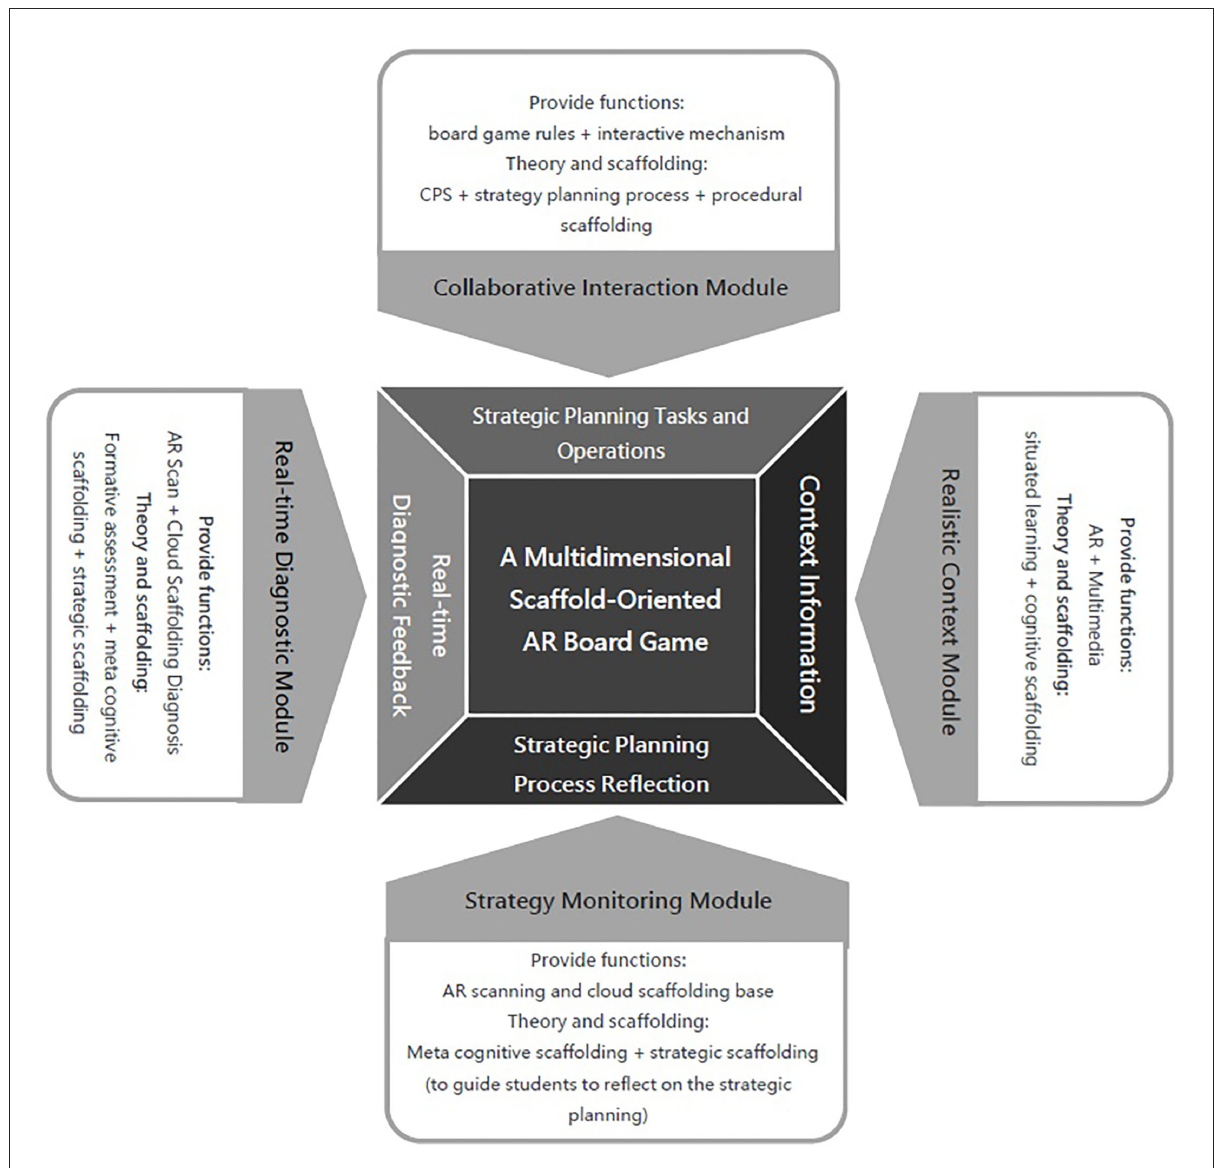
FIGURE1 Multidimensional scaffold-oriented AR educational board game framework for strategy planning ability